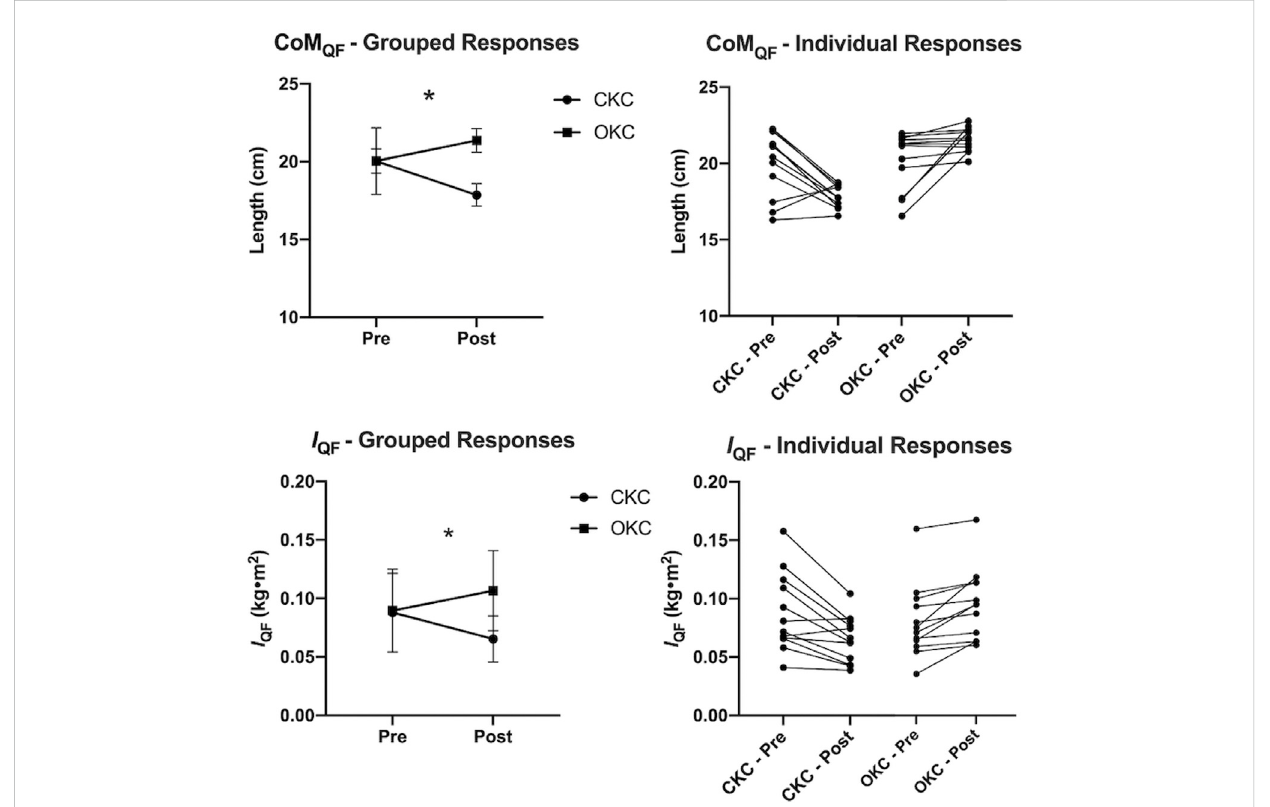
FIGURE 3 Grouped (left)andindividual (right)changesinquadricepsfemoriscenterofmasslocation(CoM QF :top)andmoment ofinertia(I QF :bottom)relative to the hip, in response to 8 weeks of open (OKC) and closed-kinetic chain (CKC) exercise. Mean and standard deviation are reported with signi fi cant differences ( p ≤ 0.05) between interventions over time (interaction effect) are represented by * ( n =